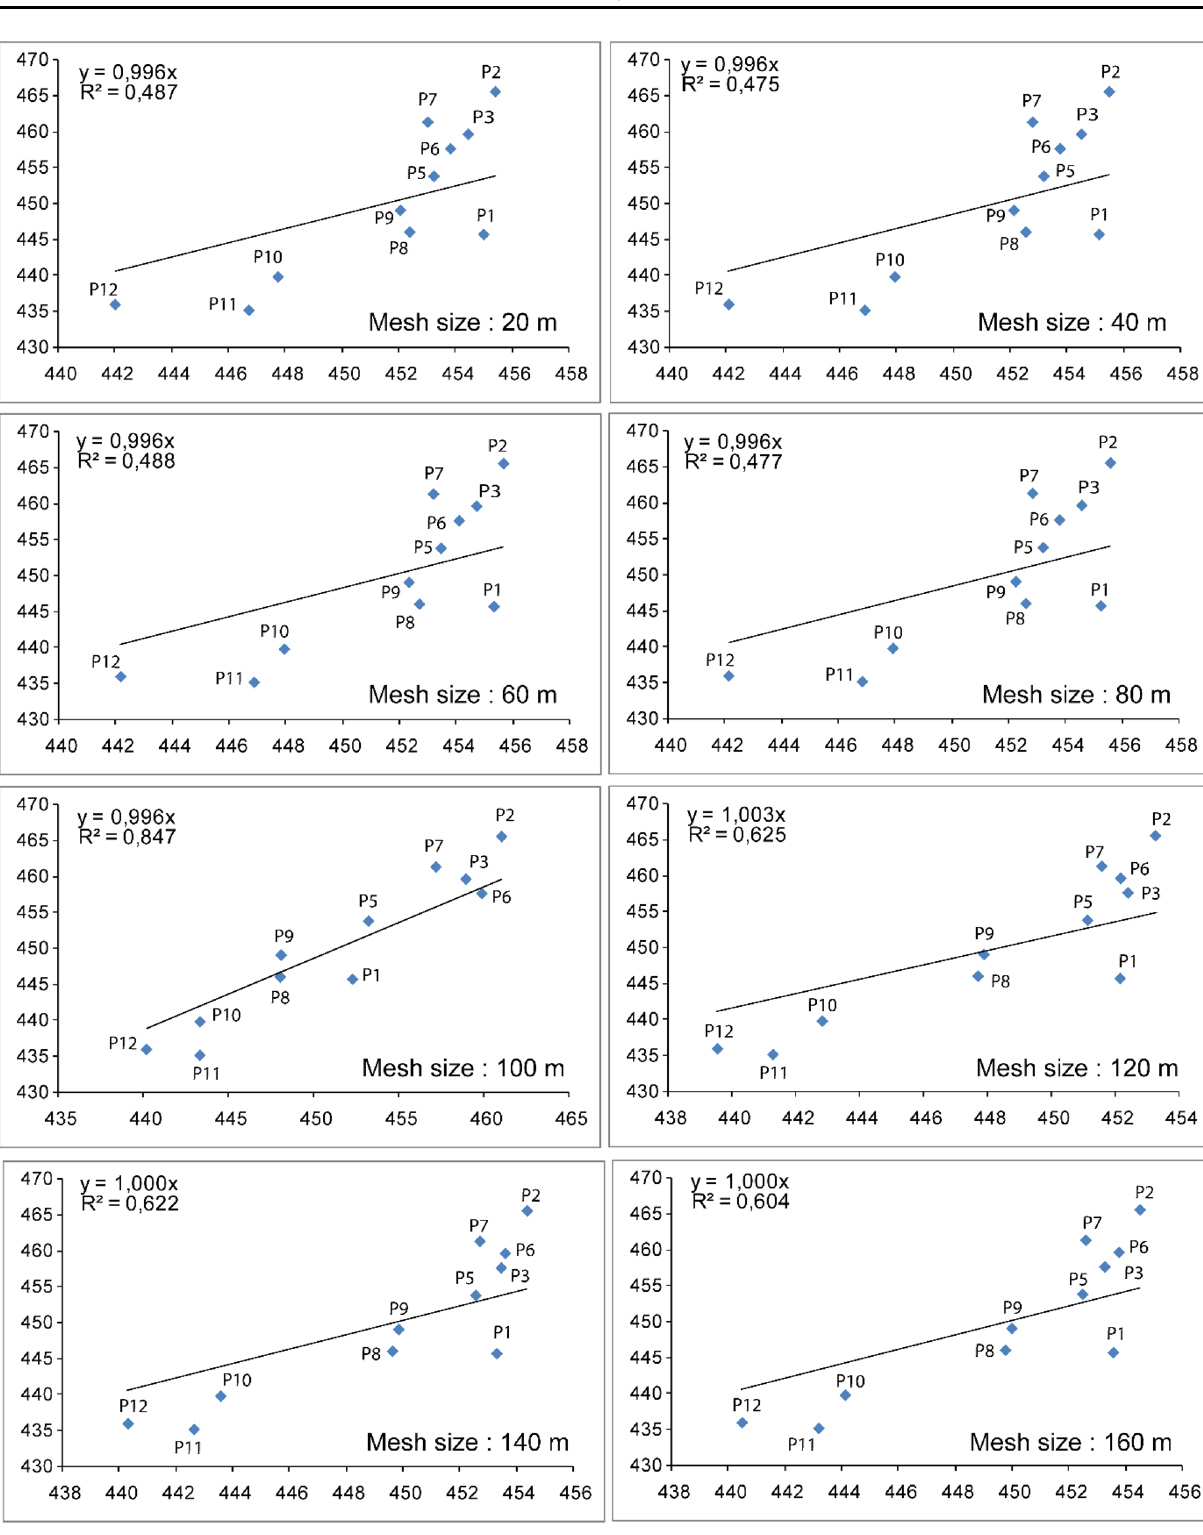
Fig. 6 Scatter plots of observed and computed hydraulic heads for different mesh